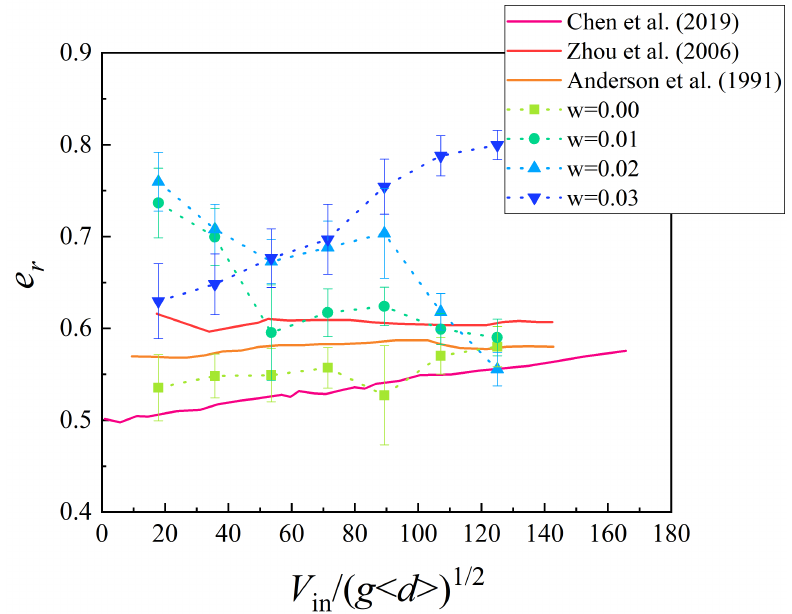
Figure 8. The restitution coefficients of the incident grain in the sand-bed collision under different surface moisture